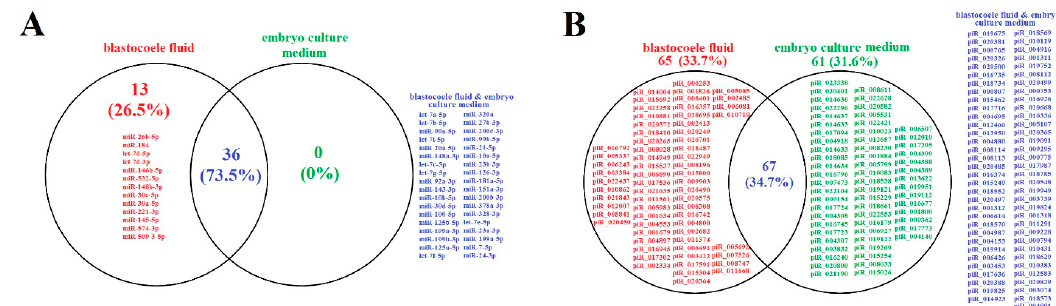
Figure 1. Venn diagrams for microRNA (miRNA) expression pattern ( A ) and piwi-interacting RNA (piRNA) expression pattern ( B ). The sncRNAs (miRNA and piRNA) unique to the blastocoele fluid are written in red; sncRNAs written in green are unique to the blastocyst spent culture medium by the fifth day after fertilization; sncRNAs are written in blue provided that they are detected both in the blastocoele fluid and in the blastocyst spent culture medium.